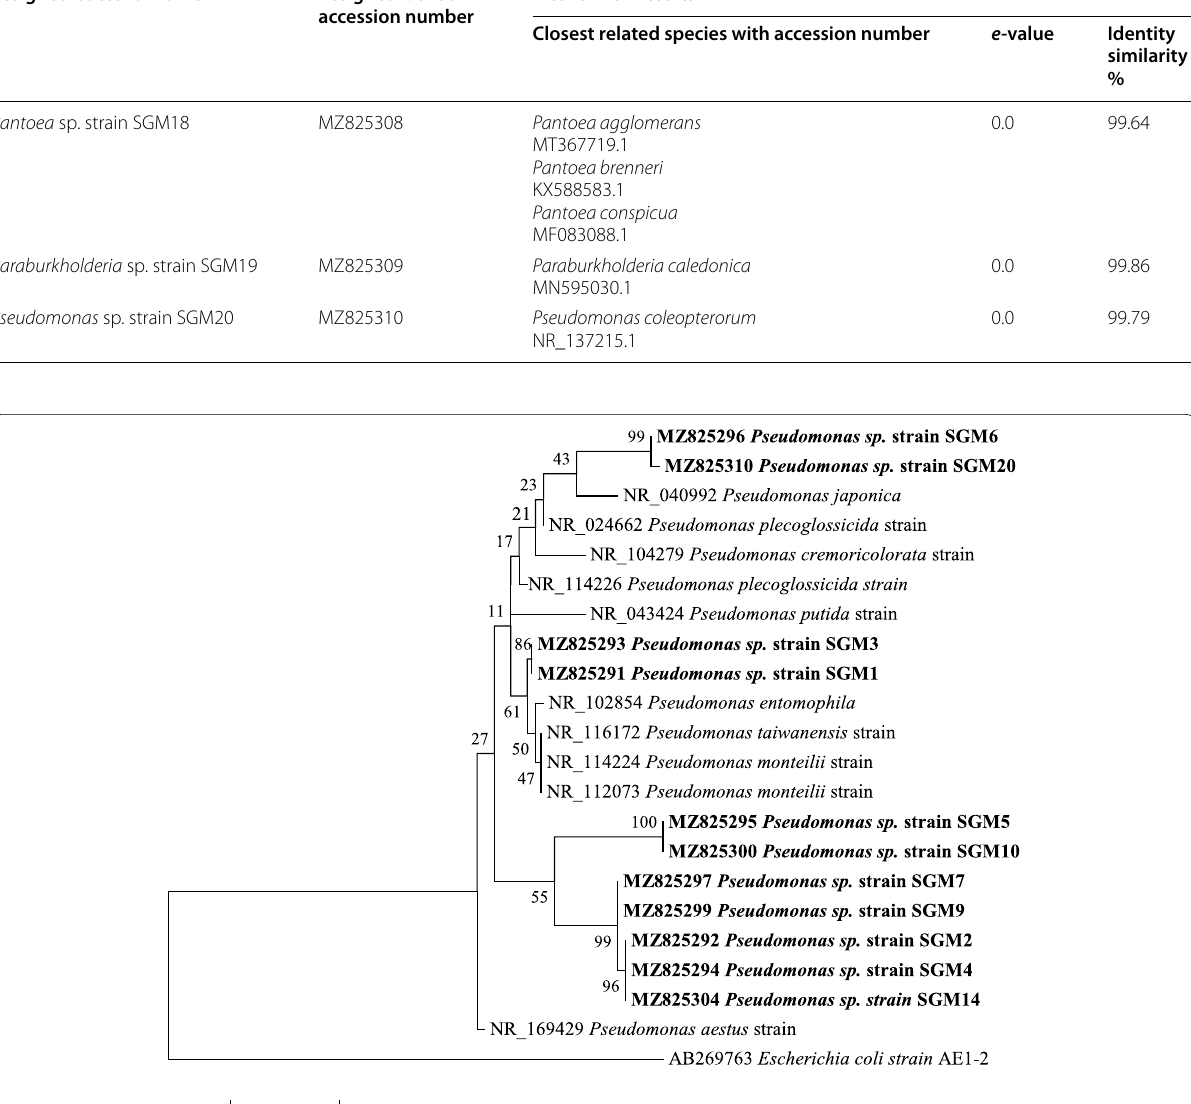
Fig. 1 Maximum likelihood phylogenetic tree based on analysis of partial 16S rRNA nucleotide sequences of Pseudomonas sp. strain SGM1, Pseudomonas sp. strain SGM2, Pseudomonas sp. strain SGM3, Pseudomonas sp. strain SGM4, Pseudomonas sp. strain SGM5, Pseudomonas